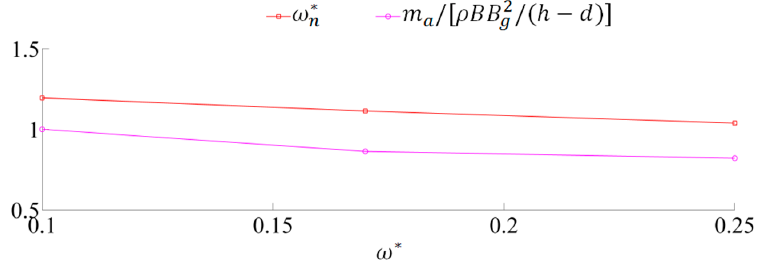
(cid:104) (cid:105) ρ BB 2 ( h − d ) decreases g /